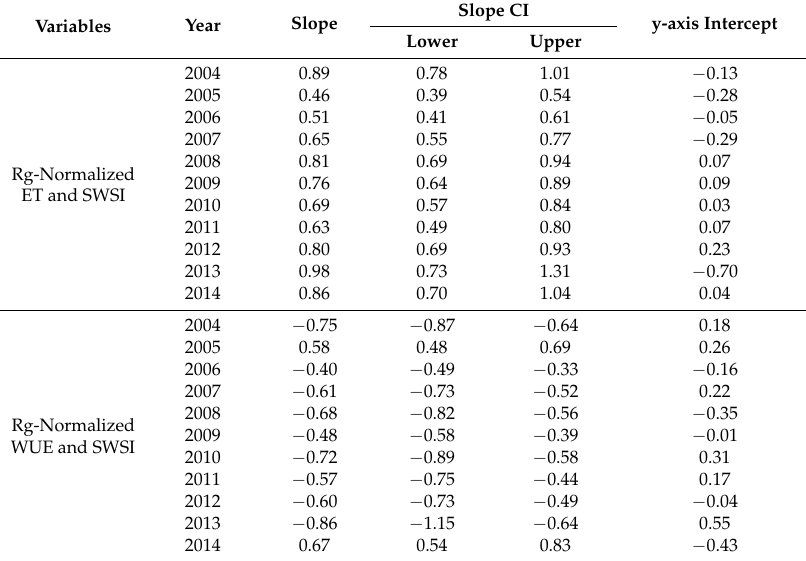
Figure A1. Interannual variations in soil water stress index (SWSIa), an eco-hydrological drought indicator. Daily data was used from 2004–2014. Tukey honest significant difference tests were performed for pairwise comparisons; years which were not significantly different at p < 0.05 are represented by the same letter. In the boxplots, the thick line shows the median, the box extends to the upper and lower quartiles, dashed lines indicate the nominal range, and open circles indicate points which lie outside of the nominal range. The greater SWSIa is, the lower soil water stress is. Table A1. Regression coefficients between Rg-normalized ET or Rg-normalized WUE and soil water stress index (SWSI). Slopes with 95% confidence intervals (CI) and y-axis intercepts according to the SMA analysis are shown. Daily data over the 2004–2014 period were used.